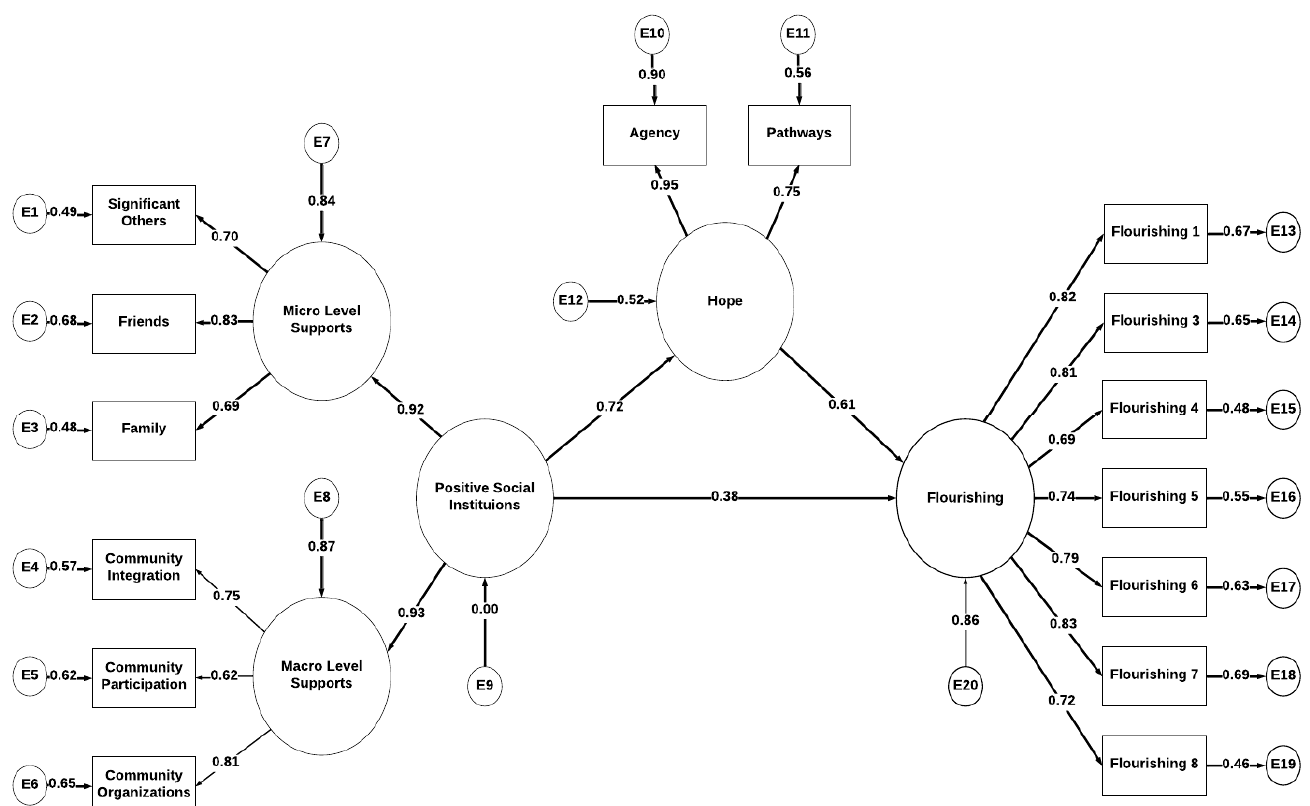
Figure 2. Standardized path coefficients for sexual and gender minority. Notes: All path values sig-